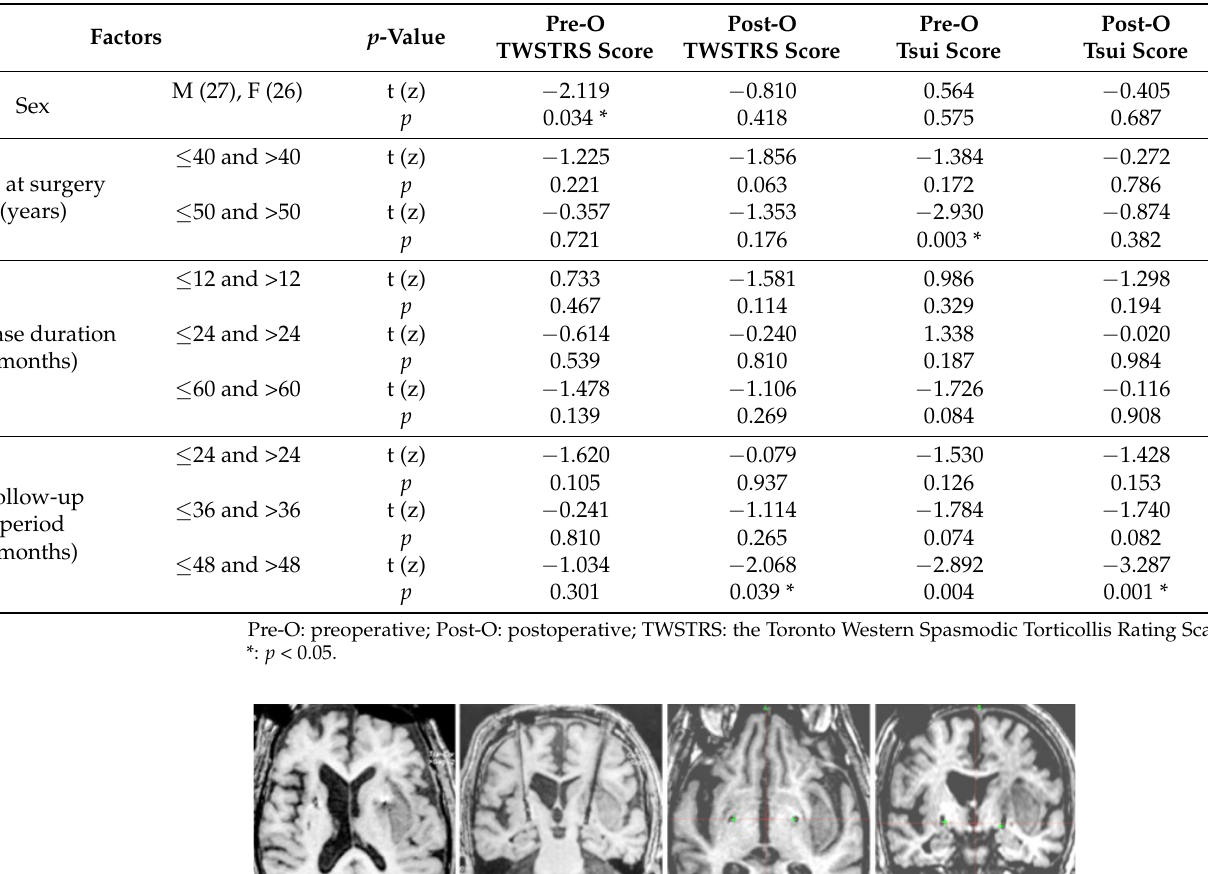
Figure 3. Globus pallidus internus DBS. ( a – d ): Axial and coronal T1-weighted intraoperative MR images ( a , b ). Intraoperative MR images were fused with preoperative MR images. The green “+” ( c , d ) indicates that the electrodes did not shift, despite a large hematoma. ( e – h ): A puncture trajectory was designed according to the intraoperative MR data, with the hematoma as the target. A drainage tube (black arrow) was placed in the hematoma ( f ). Several days later, CT showed that the hematoma had completely drained and that the electrode position was acceptable ( g , h ).